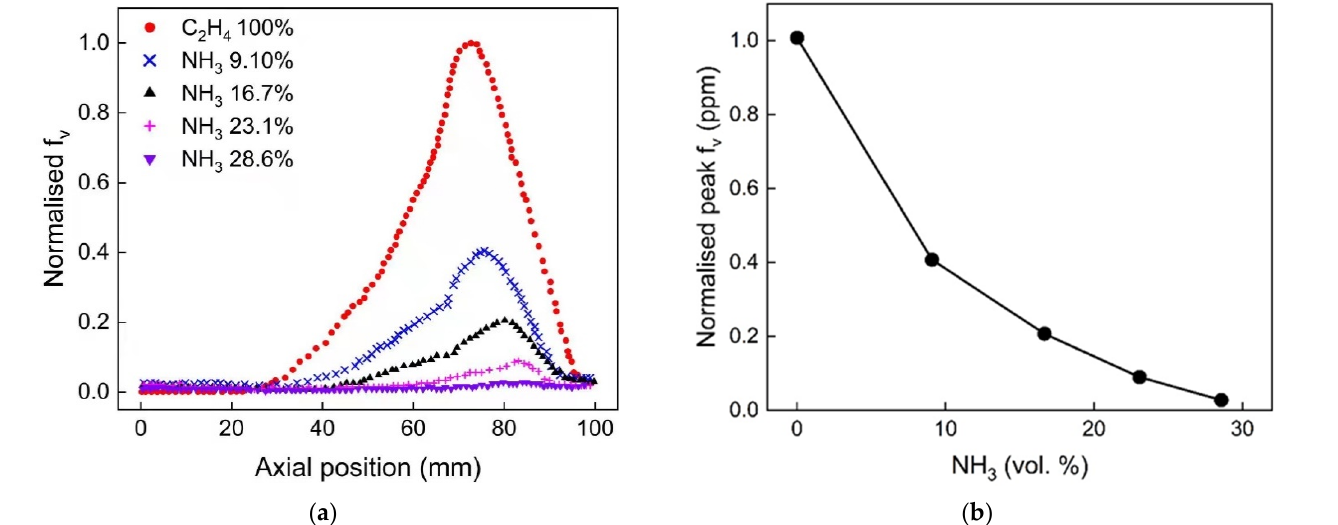
Figure 7. Comparison of the ( a ) centerline axial profile of normalized SVF and ( b ) peak SVF for different C 2 H 4 ‐ NH 3 flames with the baseline C 2 H 4 flame. The C 2 H 4 was supplied at constant flow rate of 0.18 LPM.